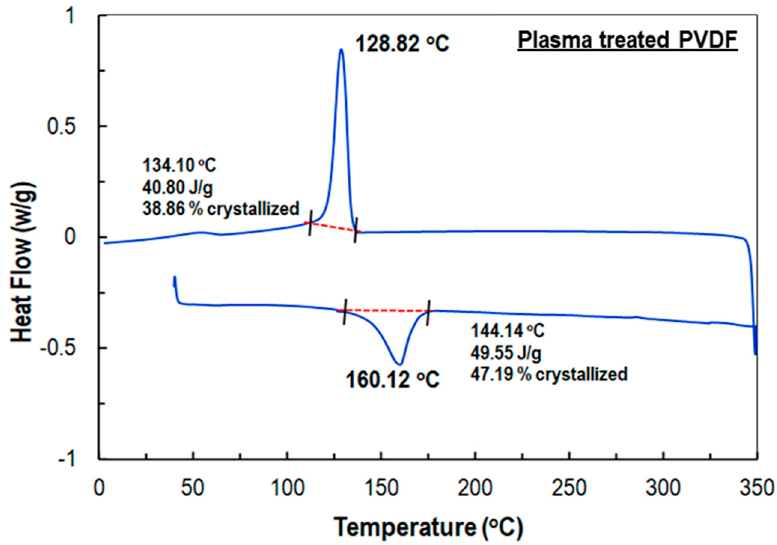
Figure 5. DSC thermogram of a plasma treated PVDF sample. Table 1. Comparison of crystallization point, enthalpy, and crystallization percentage of a pristine and plasma treated PVDF fibers.